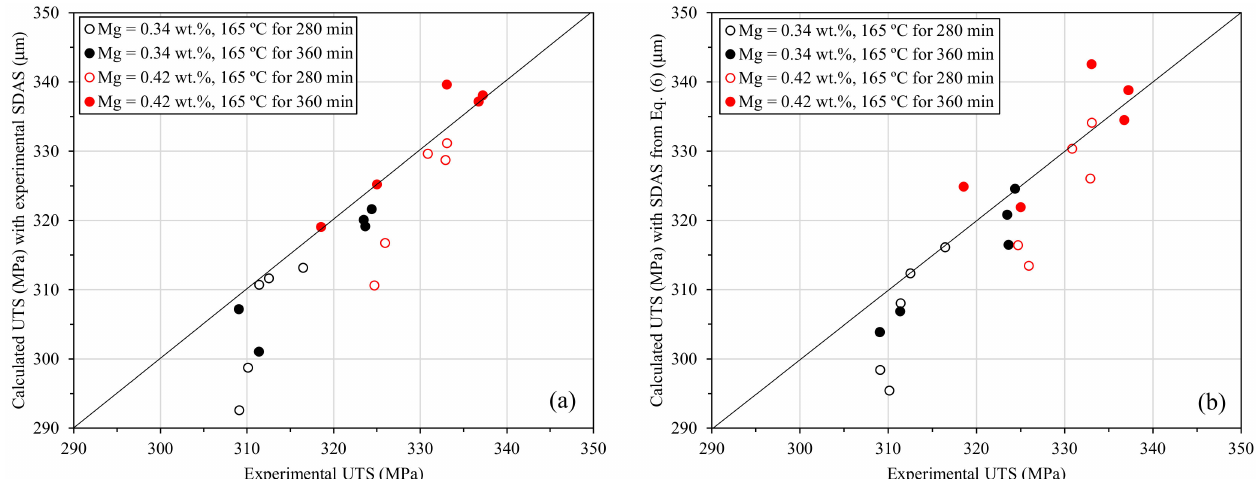
Figure 19. Comparison of experimental UTS values obtained from the SK-7 castings and those predicted by using Equation (28) and data included in Table 11. Two different SDAS parameters are used: experimentally measured SDAS ( a ) and the values of this parameter determined with Equation (6) ( b ). Black symbols correspond to SK-7 castings manufactured with 0.34 wt.% Mg while red symbols correspond to castings produced with 0.42 wt.% Mg. In both cases, open and solid circles represent those castings aged at 165 ◦ C for 280 min and for 360 min, respectively. Solid lines are the